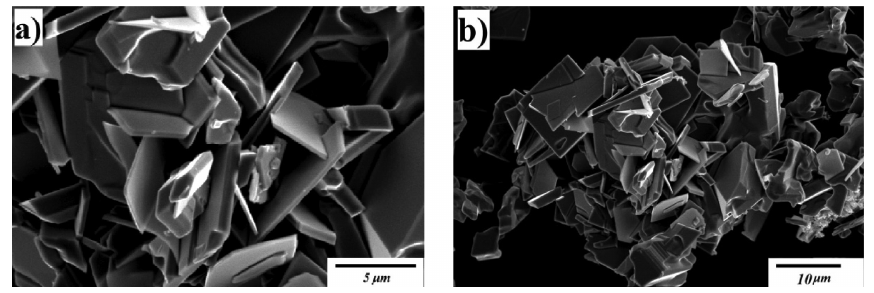
Fig. 1: Morphologies of MoO 2 powders: (a) amplified by 5000 times; (b) amplified by 2000 times